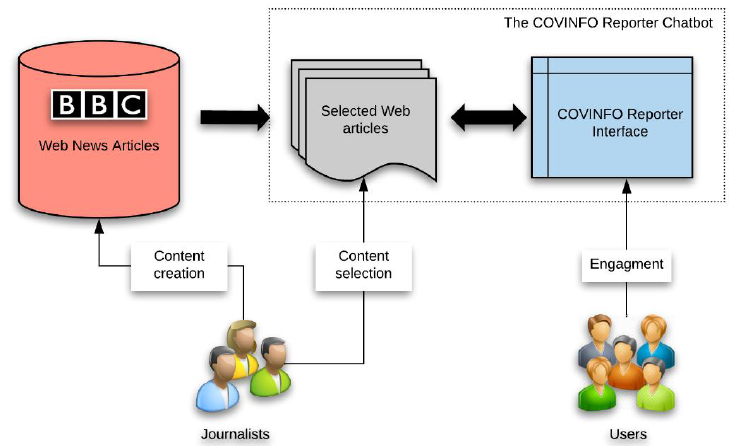
Figure 2. User and journalist interactions with the COVINFO Reporter chatbot.